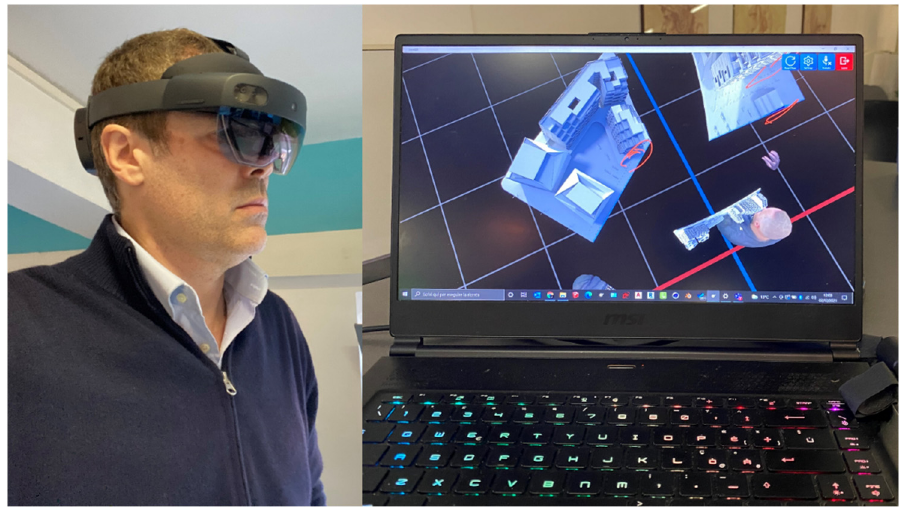
Figure 7. MR collaborative environment with MS HoloLens 2.